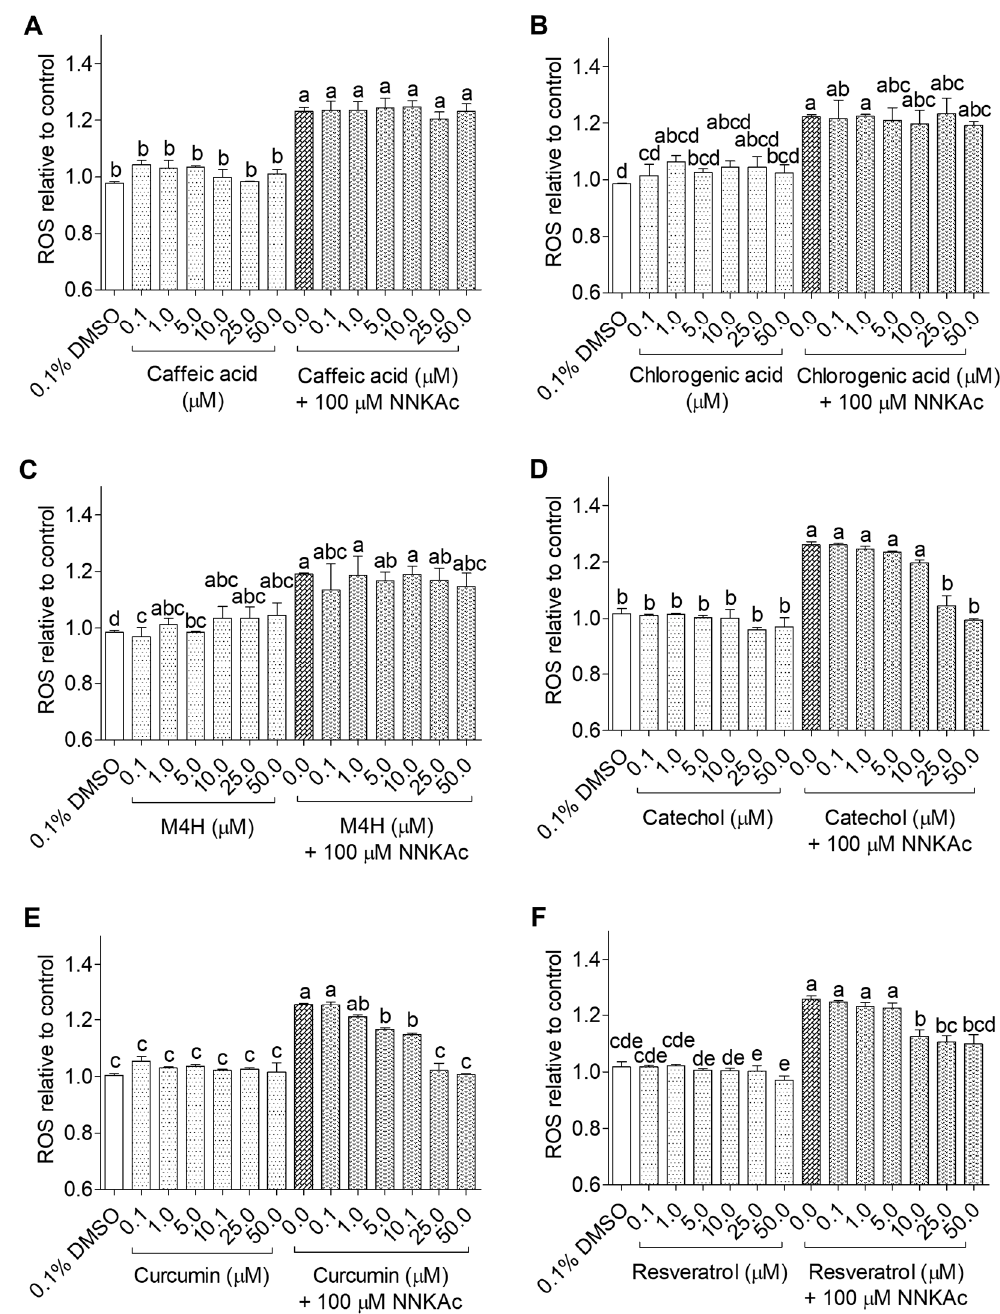
Figure 4. Effect of caffeic acid ( A ), chlorogenic acid ( B ), methyl 4-hydroxybenzoate ( C ), catechol ( D ), curcumin ( E ), and resveratrol ( F ) on reducing NNKAc-induced ROS in BEAS-2B cells. Cells were pre-treated with concentrations ranging from 0.1 to 50 µM of selected phenolic acids and other (poly)phenols for 3 h. Pre-treated cells were exposed to 100 µM NNKAc for another 3 h to induce ROS generation. DMSO (0.1%) was used as the vehicle control. Effects on ROS levels were quantified using DCFDA fluorescence assay. Two independent studies ( n = 3) were performed, and results were expressed as mean ± standard deviation. Statistical analysis of data was performed by one-way ANOVA and mean comparison was done by Tukey’s mean comparison method ( α = 0.05) using Minitab 19 statistical software (LLC, Pennsylvania, USA). Mean values that do not share similar letters in bar graphs are significantly different ( p < 0.05). Abbreviations: M4H: methyl 4-hydroxybenzoate NNKAc: 4-[(acetoxymethyl)nitrosamino]-1-(3-pyridyl)-1-butanone, DCFDA: 2 ′ 7 ′ -dichlorofluorescein diacetate, ROS: reactive oxygen species, DMSO: dimethylsulfoxide.